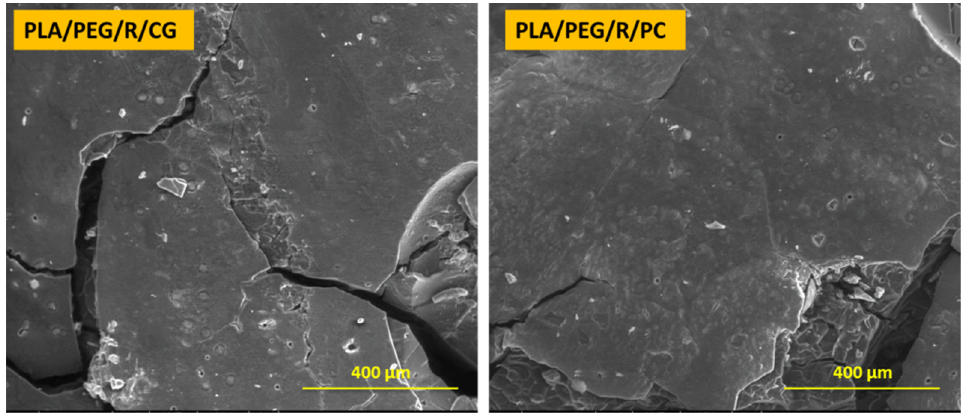
Figure 3. SEM micrographs (magnification of 250×, scale bar—400 µm) of PLA/PEG/R sample after 14 days incubation with Chaetomium globosum (CG) and Phanerochaete chrysosporium (PC) fungi.